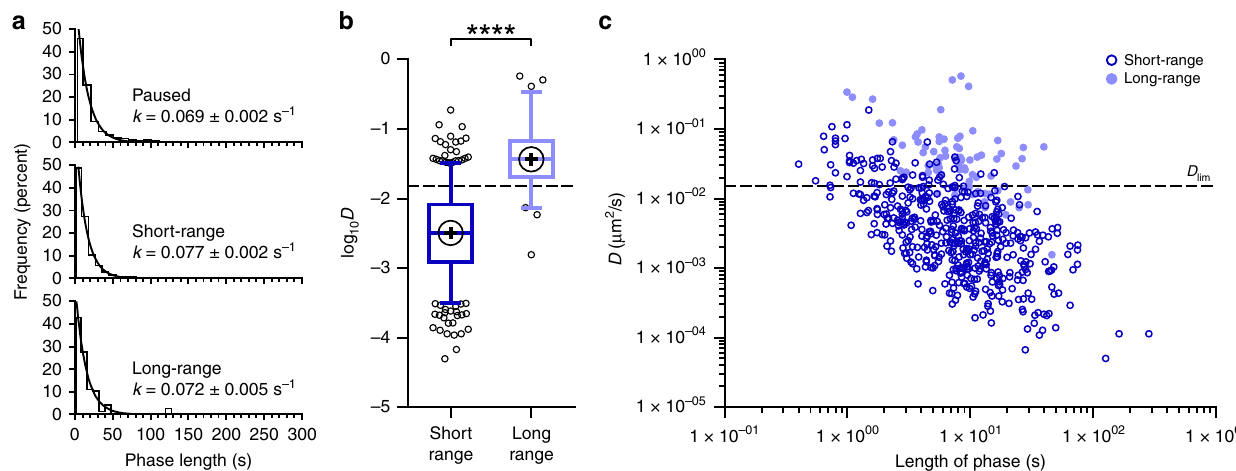
Fig. 6 Short-range motion is associated with a lower diffusion coef fi cient. a Cumulative frequency distributions of the lengths of paused ( n = 774 phases), short-range ( n = 819 phases), and long-range ( n = 145 phases) phases for XPA on combined λ substrates (ND λ , UV λ 20J , and UV λ 80J ). A single exponential is fi t to each histogram and resulting k is reported as best fi t value ± s.e. of the fi t. Mean lifetime, τ = 1/ k . b Box and whisker plot (5-95 percentile) of the diffusion coef fi cient (log 10 D ) calculated for short-range ( n = 505 phases) and long-range ( n = 79 phases) phases of fl XPA on combined λ substrates (ND λ , UV λ 20J , and UV λ 80J ). + , sample mean. Dashed line, D lim , theoretical limit to free diffusion for Qdot- fl XPA. **** p < 0.0001 by two-tailed Student ’ s t test. c Plot of diffusion coef fi cient ( D ) vs. length of phase (same phases shown in b ). Dashed line, D lim , theoretical limit to D for free diffusion of Qdot- fl